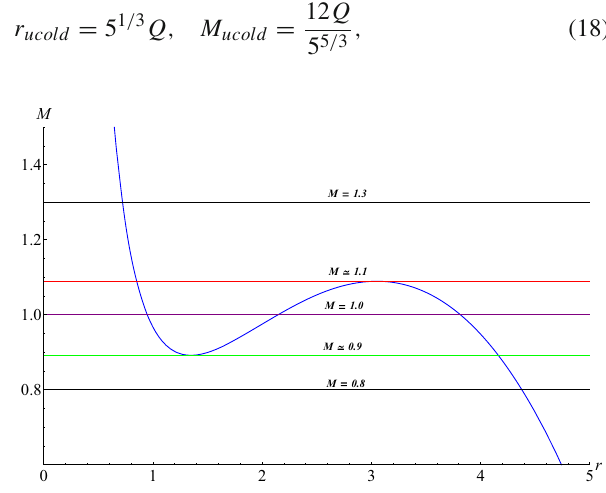
Fig. 1 Themassfunction M ( r ) isplottedintermsofthehorizonradius r , at Q = 1 and (cid:2) = 1 / 10. The black lines ( M = 0 . 8 and M = 1 . 3) correspondtonoblackhole.Thepurpleline( M = 1 . 0)correspondstoa black hole of three different horizons. The red and green line ( M (cid:9) 1 . 1 and M (cid:9) 0 . 9) corresponds to black holes whose two of three horizons coincide